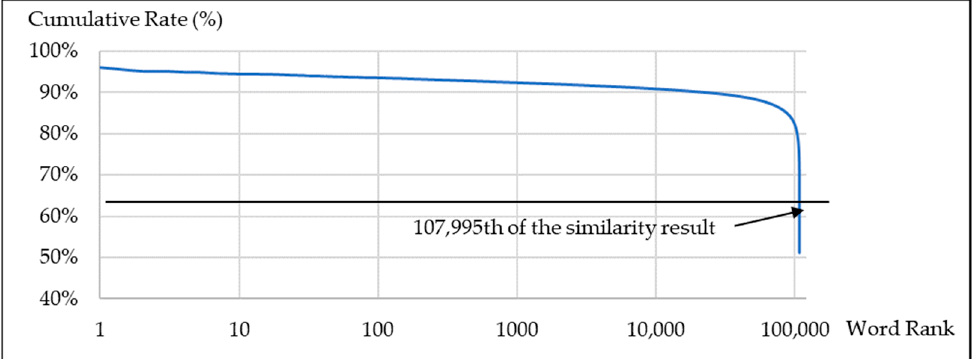
Figure 9. The cosine similarity in ascending order of the dev. set; the x-axis presents the number of sentences on a log scale; the y-axis shows the percentage of the cosine similarity.